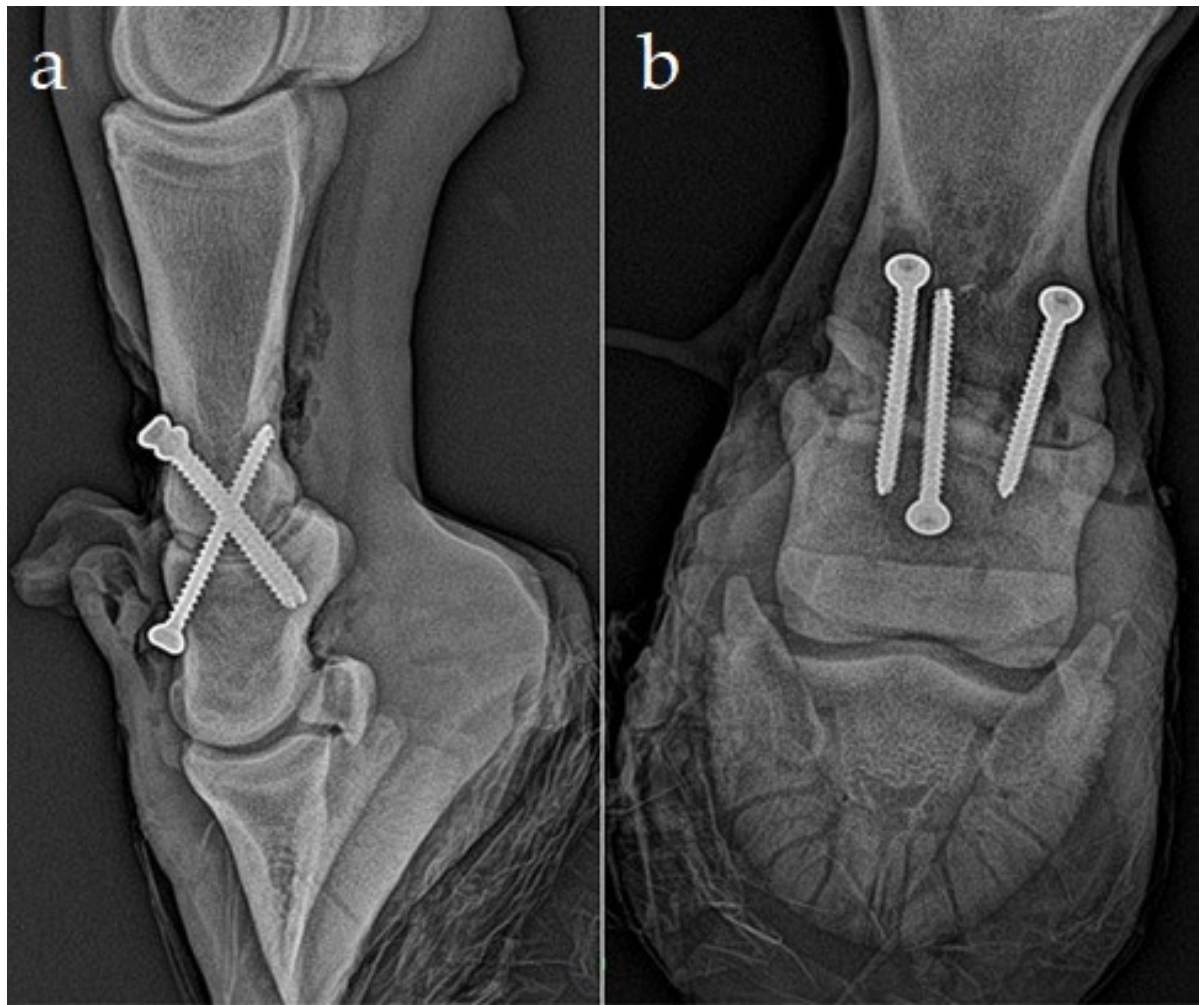
Figure 3. Lateromedial ( a ) and dorsoproximal–plantarodistal oblique projection ( b ) control radiographs of the proximal interphalangeal joint arthrodesis during the surgery.